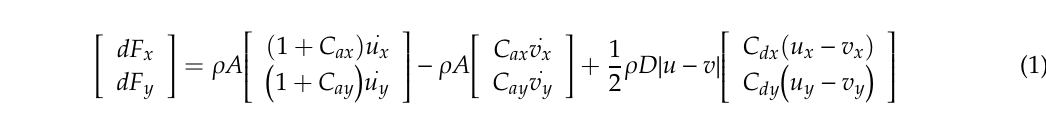
Figure 8. Low-order mesh considered in the WAMIT code analysis.